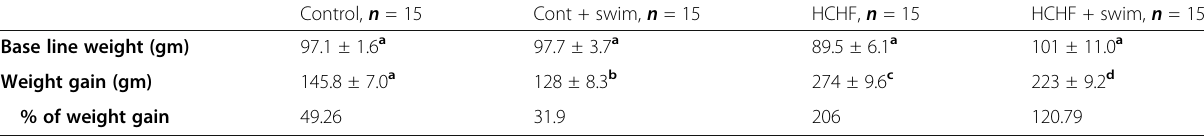
Table 1 Weight of rats in different studied groups